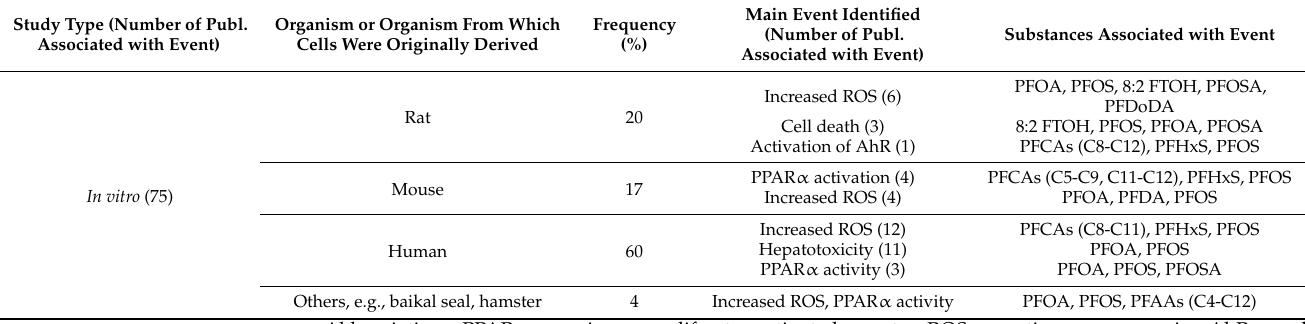
Table 2. In vitro study outcomes related to metabolic